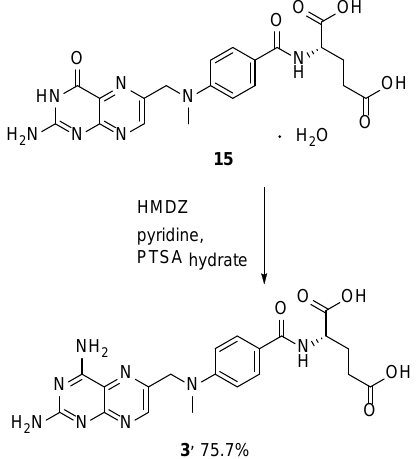
Scheme 6. Synthesis of MTX from 4-oxoderivative of MTX (methopterin hydrate) ( 15